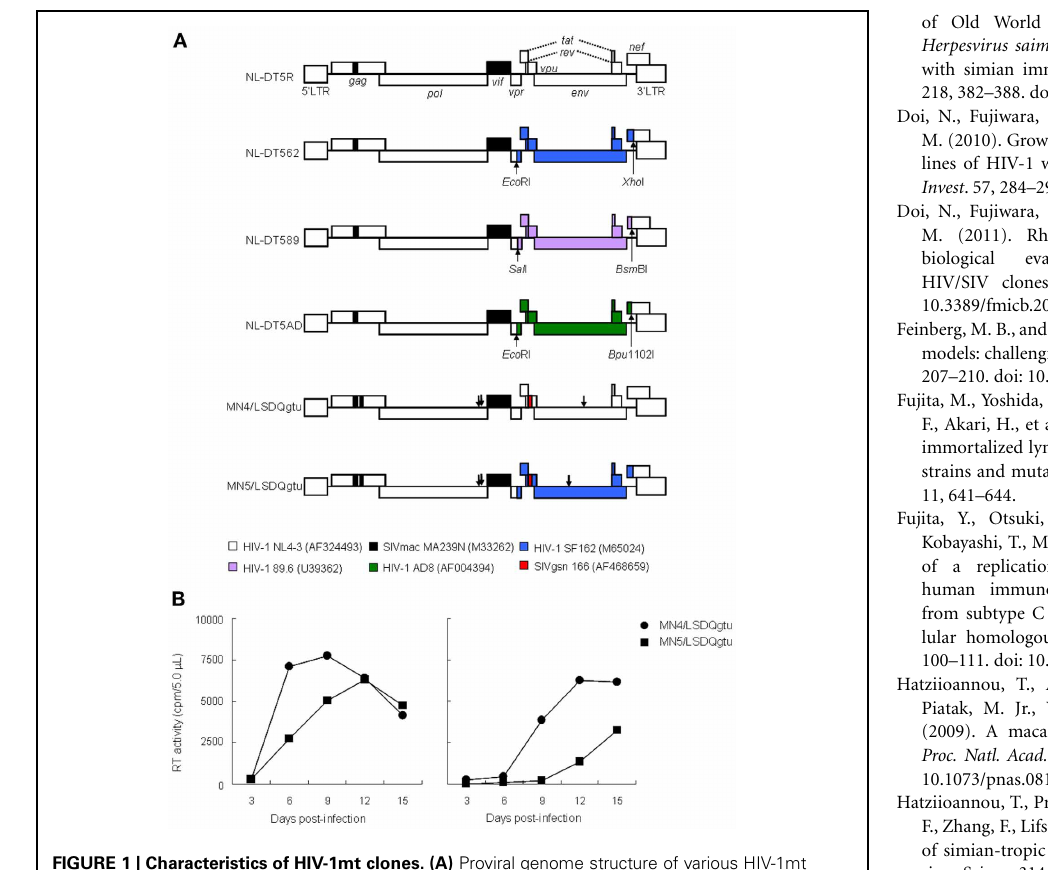
FIGURE 1 | Characteristics of HIV-1mt clones. (A) Proviral genome structure of various HIV-1mt clones. Genomes of various HIV-1mt clones generated in our laboratory are schematically illustrated. White and black (a small portion of gag -capsid and an entire vif ) areas stand for the genomic regions of HIV-1 NL4-3 (Adachi et al., 1986) and SIVmac MA239N (Shibata et al., 1991; Doi et al., 2010), respectively. The other colored regions are the sequences derived from various SIV/HIV-1s as shown. Restriction enzyme sites used for the insertion of these sequences into NL-DT5R are also shown. GenBank accession numbers are indicated in parentheses. Arrows represent the adaptive mutation sites in pol -integrase and env -gp120 that enhance virus growth potentials (Nomaguchi et al., 2013b). While NL-DT5R and MN4/LSDQgtu are CXCR4-tropic viruses, NL-DT562, NL-DT5AD, and MN5/LSDQgtu are CCR5-tropic. Although examined in macaque cells, the growth ability of NL-DT589 is not yet proven (see text). mac, rhesus macaques; gsn, greater spot-nosed monkeys. (B) Viral replication kinetics in M1.3S cells. Cell-free viruses were prepared from 293T cells transfected with proviral clones indicated, and equal amounts [5 × 10 6 and 5 × 10 5 reverse transcriptase (RT) units for left and right panels, respectively] were inoculated into M1.3S cells (2 × 10 6 cells). Viral replication was monitored at intervals by RT activity in the culture supernatants. The experiments were done as described previously (Kamada et al., 2006). M1.3S is the most refractory cell line to infection with SIVmac/HIV-1mt clones to the best of our knowledge, but is CD4-, CXCR4-, and CCR5-positive. NL-DT5R and NL-DT562 do not grow at all in M1.3S